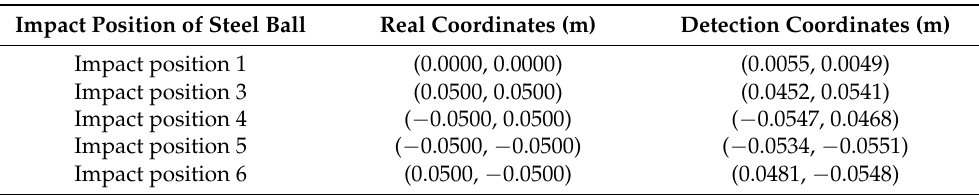
Table 4. Comparison of experimental results and actual positions.